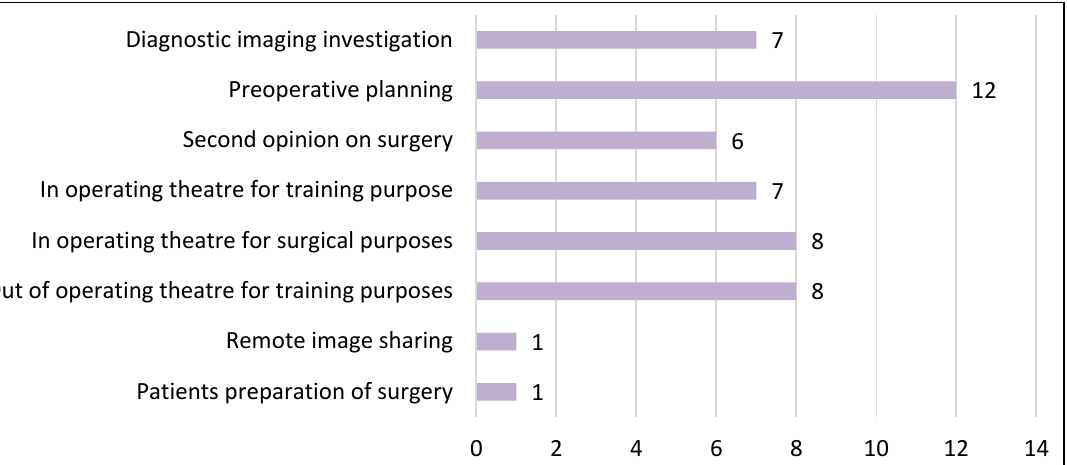
Figure 8. Subject’s answers to future useful uses of MR visualization (multiple choice).